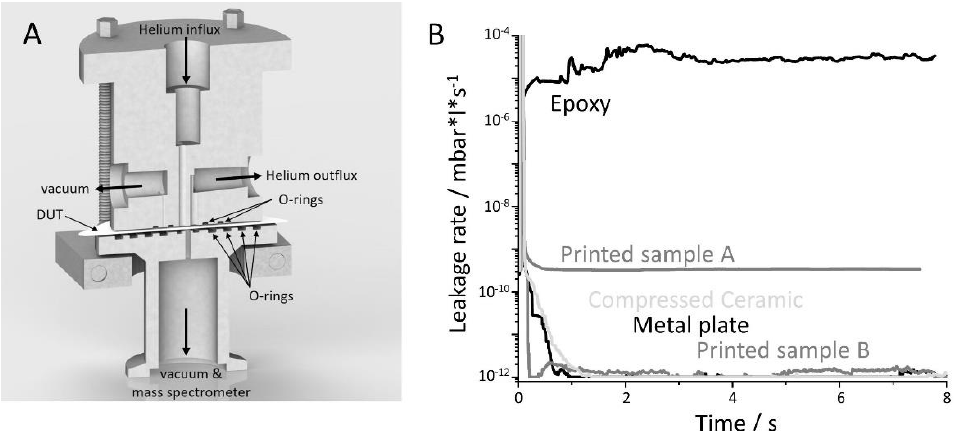
Figure 3. Helium leakage tests with the printed ceramics and positive as well as negative controls. ( A ) A volume-free helium leakage head to clamp a flat device under test (DUT) between different O-rings. Constant helium pressure of 1.1 bar is applied to the DUT from above and the mass spectrometer is connected on the opposite side. Removing the helium that diffuses through the inner top O-rings via a vacuum pump reduces cross-contamination. ( B ) The limit of helium flow is reached with metal plates and thermo-compressed ceramics. The thermo-compressed ceramic, as well as the printed ceramics, can also reach the limit or show a constant helium current smaller than the Gross-Leak Limit of 10 −4 mbar  s -1 , which is almost reached with an epoxy